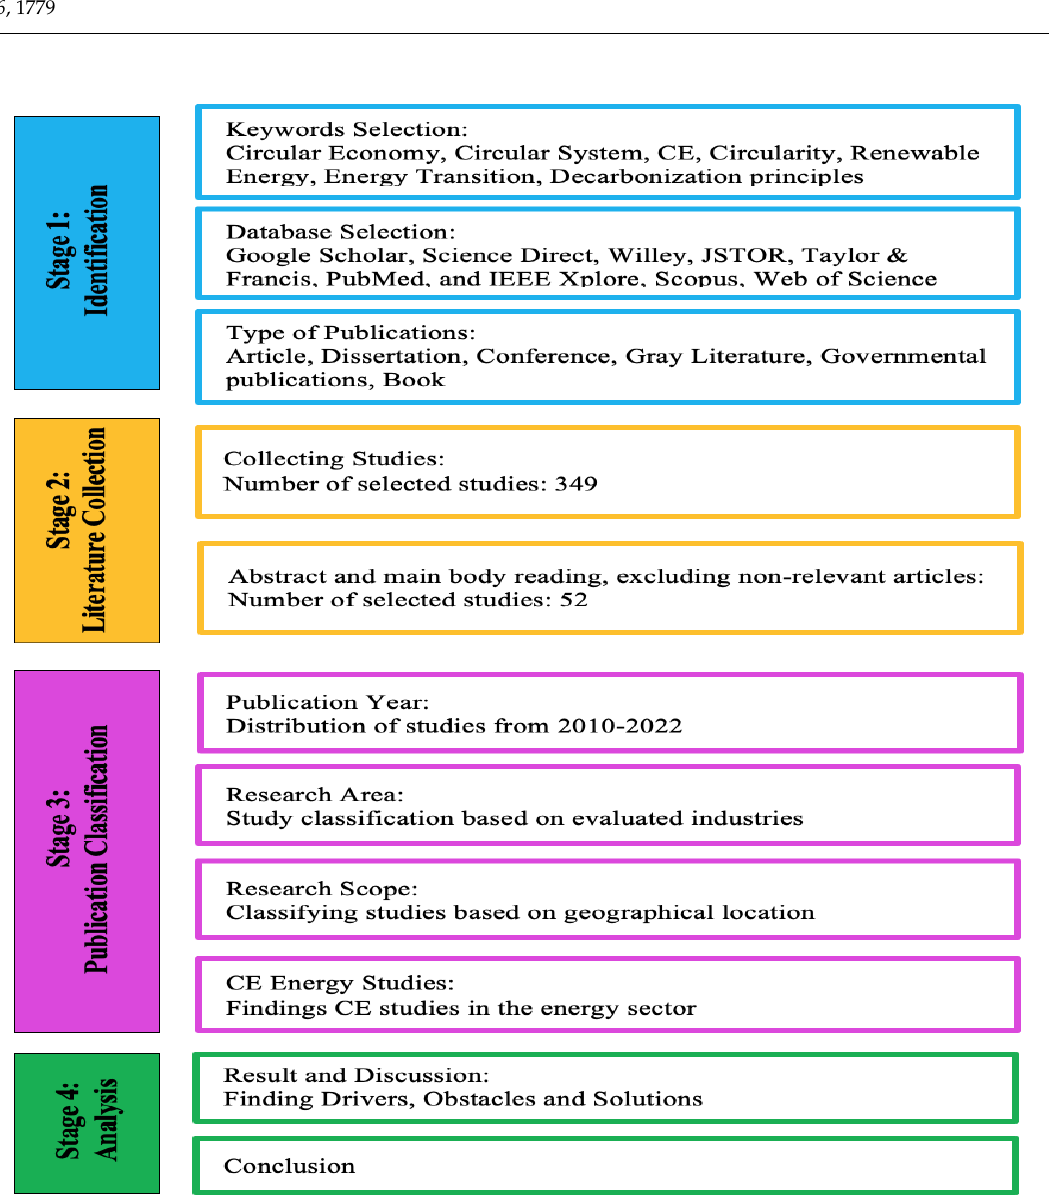
Figure 1. Framework of literature review.